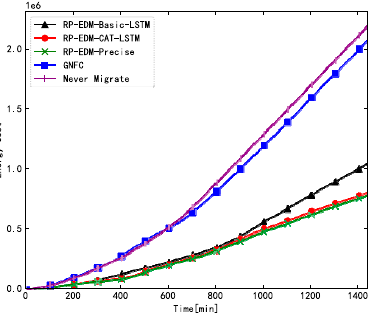
Figure 5. The total cost of RP-EDM series algorithms, GNFC and Never Migrate policy to the optimal problem is reported for the same amount of traffic being served. CPU capability of each server is equal to 1000 MIPS.